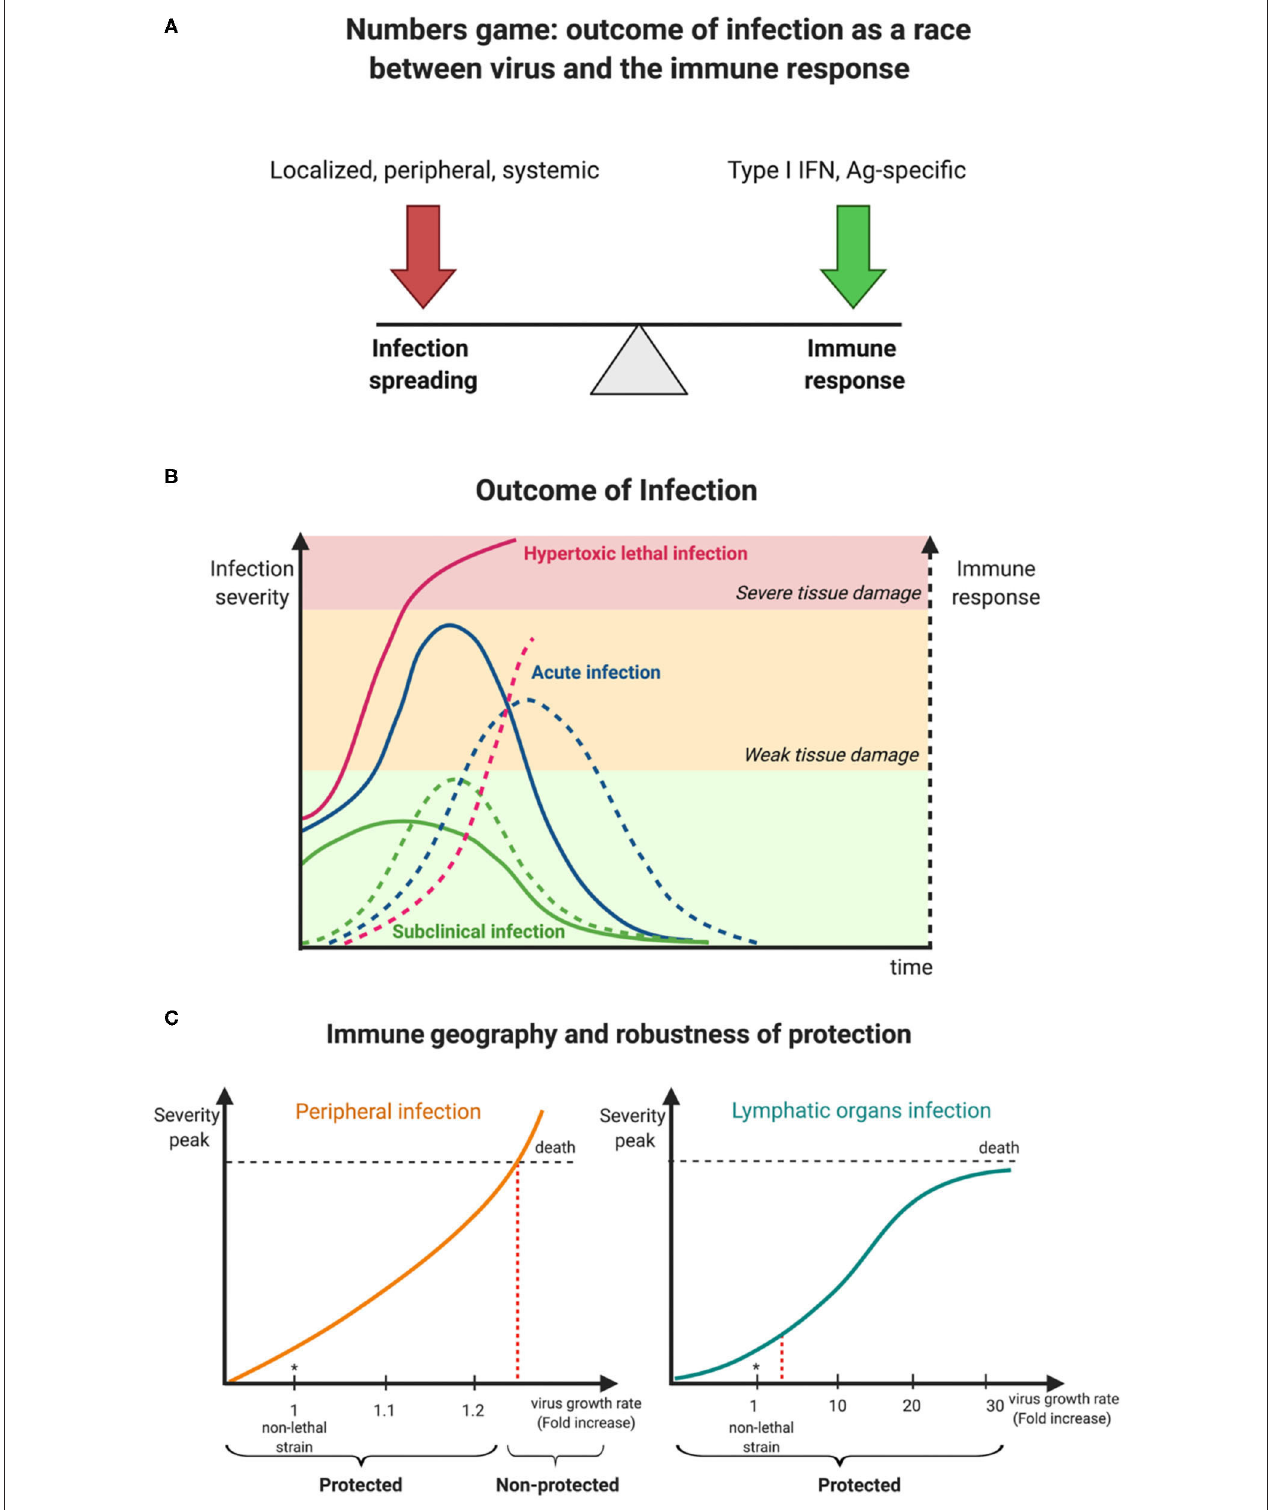
FIGURE 1 | Kinetic view on CoV pathogenesis. (A) The numbers game between virus growth and immune response determines virus infection outcomes. (B) Early innate immune responses determine viral pathogenesis. (C) Degree of robustness of protection against a faster replicating M-CoV strain in relation to its preferential site of replication, i.e., a peripheral organ (liver) vs. a lymphoid organ (spleen). Virus is represented as a solid line while broken lines characterize the immune response.